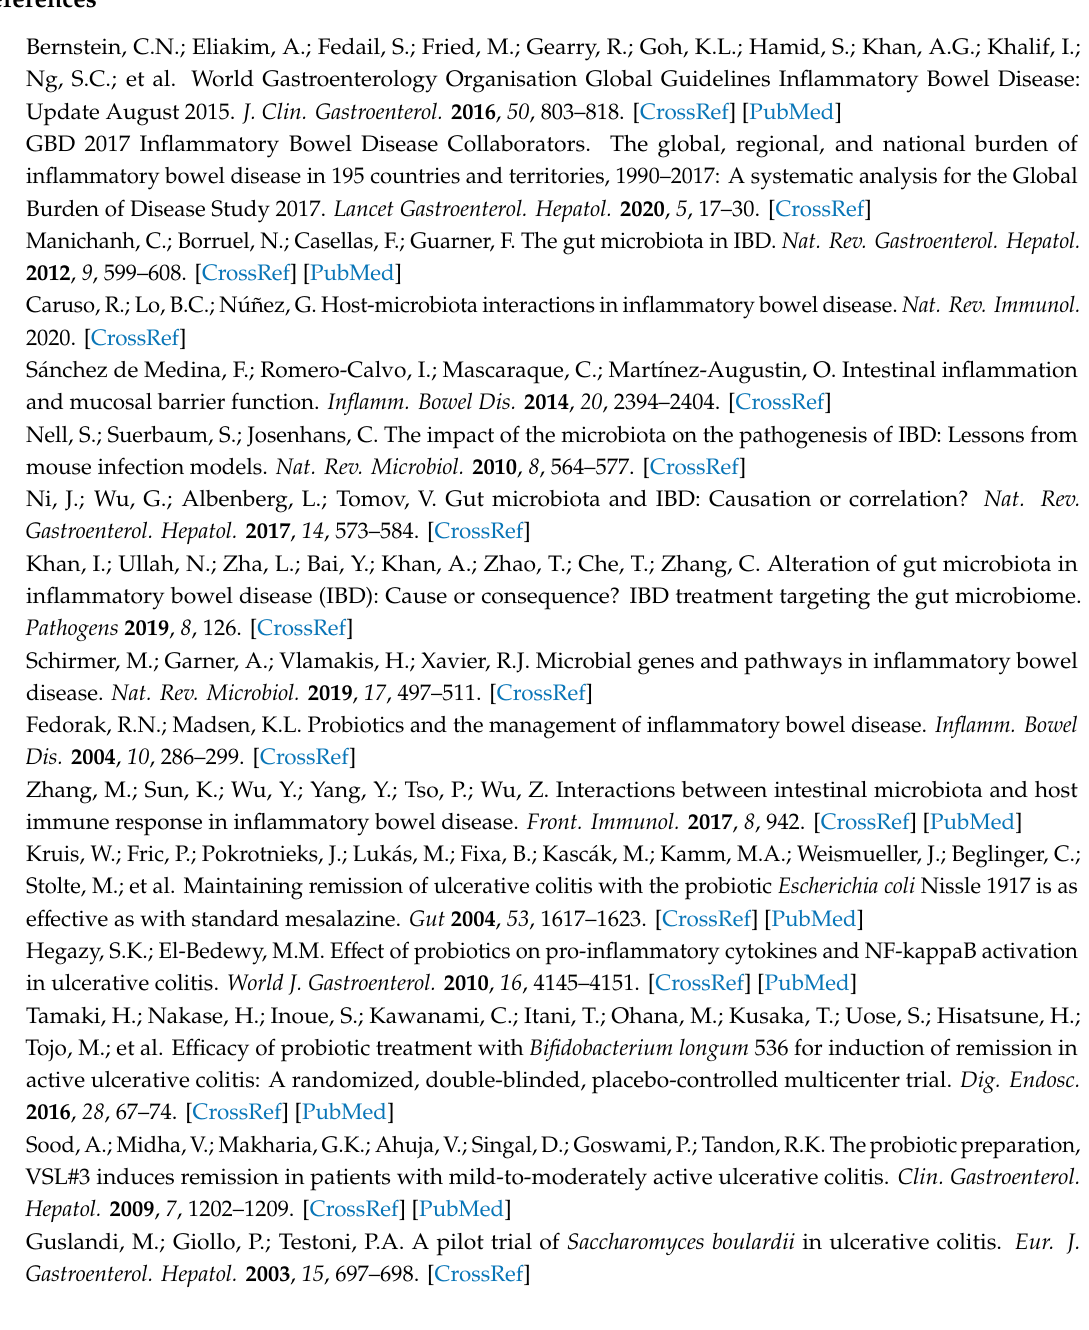
Table S1: List of primers used in this study; Supplementary Data S1: Relative abundance (%) in individual samples; Supplementary Data S2: Di ff erential abundance of DSS LDTM 7511 over the DSS group in DESeq2; Supplementary Data S3: Di ff erential abundance of DSS ATCC 53103 over the DSS group in DESeq2; Supplementary Data S4: Relative abundance (%) of the agglomerated group at a genus level; Supplementary Data S5: Pearson correlation between specific taxa and the inflammatory